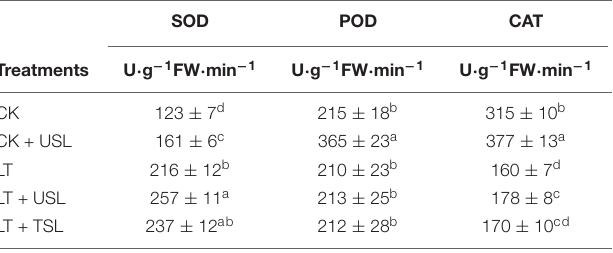
TABLE 4 | Effects of USL on the activities of antioxidant enzymes in tomato leaves under LT stress. SOD POD CAT